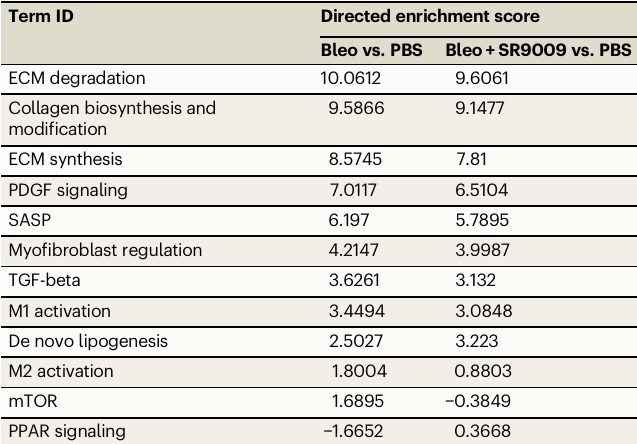
Table 1 | Dysregulated pathways after Bleomycin injury with or without SR9009 in C57 mice Term ID Directed enrichment score Bleo vs. PBS Bleo+SR9009 vs. PBS ECM